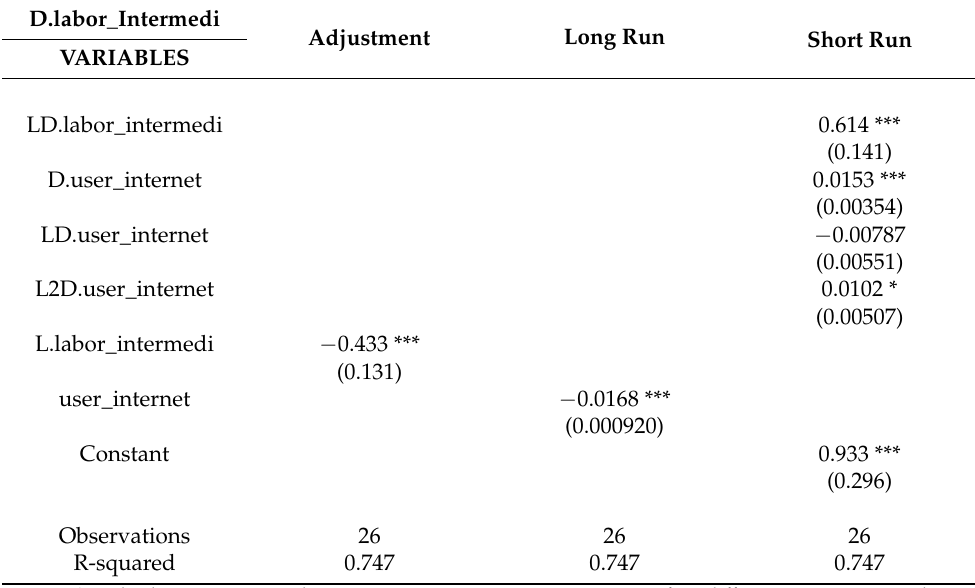
Table 4. Model 1—impact of digital transformation on labor cost efficiency